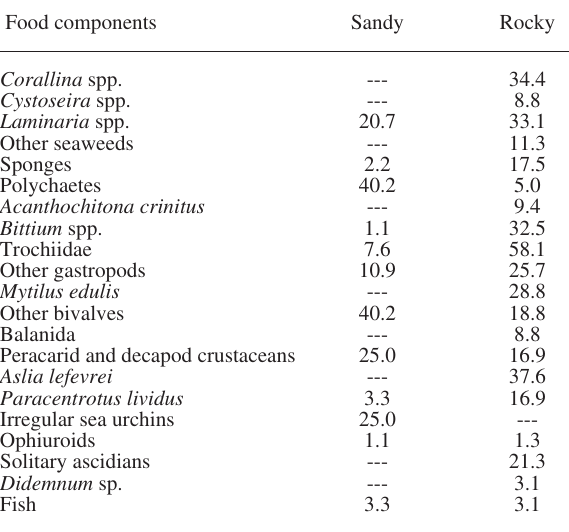
Table 1. – Frequency of appearance of food components in the gut contents of Maja brachydactyla (percentages of the total number of guts containing food are shown) in rocky (n=160, data from bernár- dez et al ., 2000) and sandy habitats (n=92, data obtained by the authors).